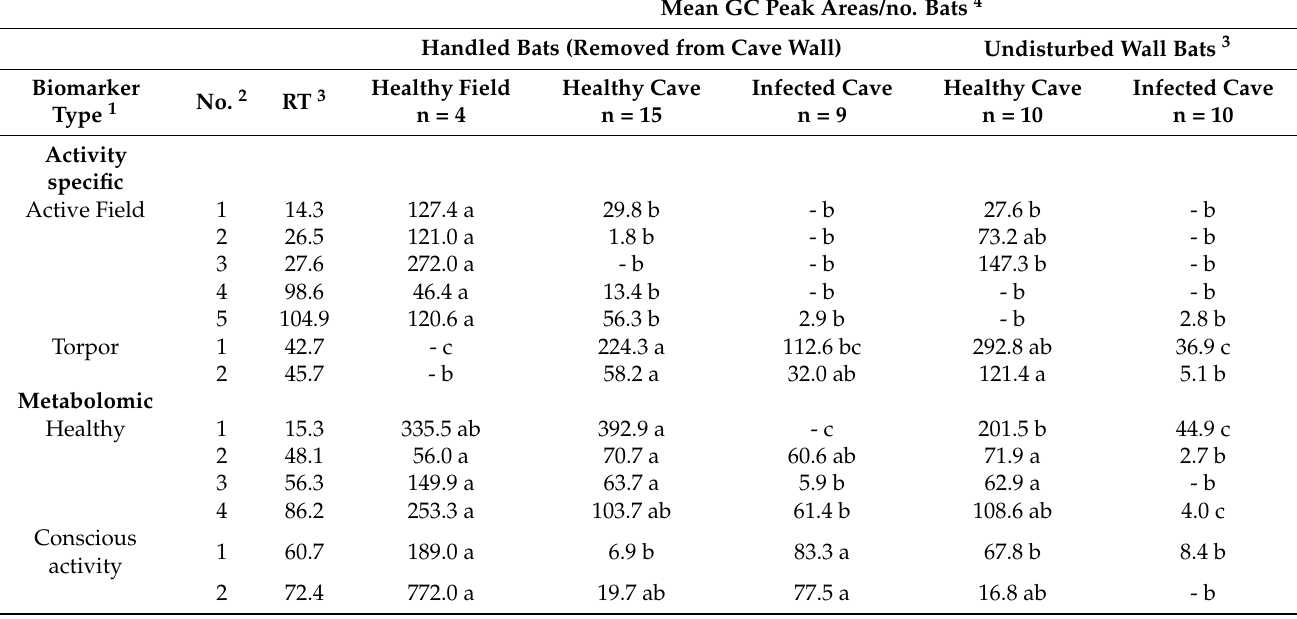
Table 7. VOC biomarkers types identified from whole-body VOC-emissions from healthy active extracave (field) bats, healthy inactive intracave bats, and WNS-diseased intracave tricolored